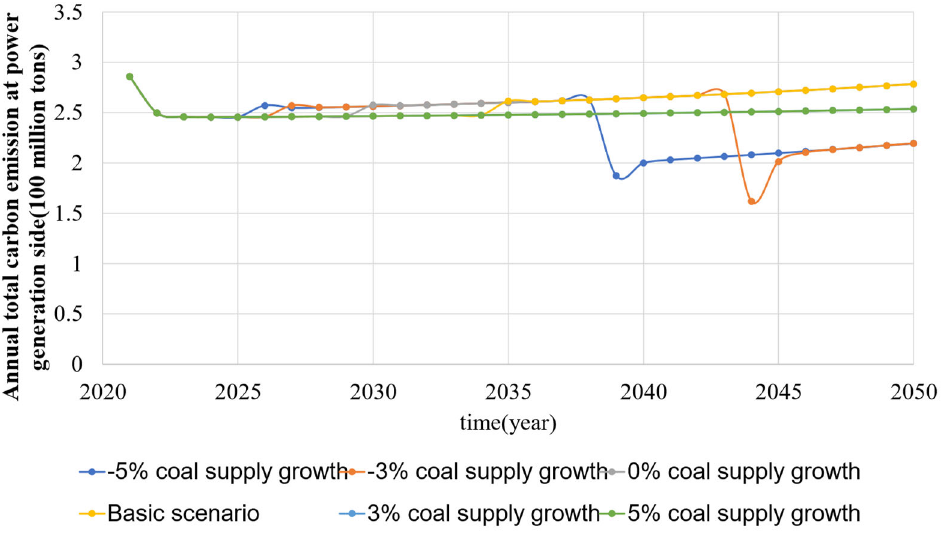
Figure 9. Annual total carbon emission change in power generation side based on coal supply growth rate.